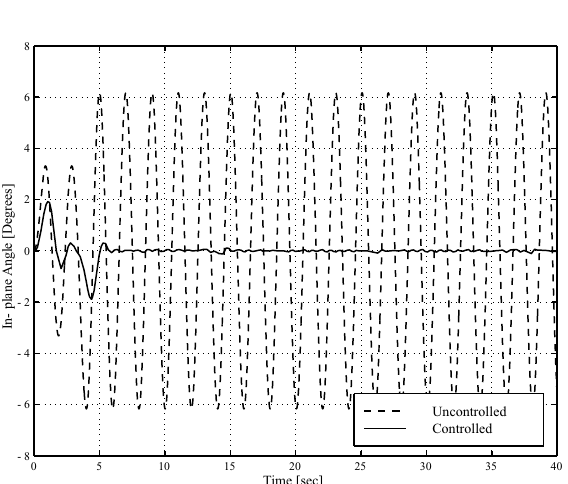
Fig. 17. Operator radial signal.